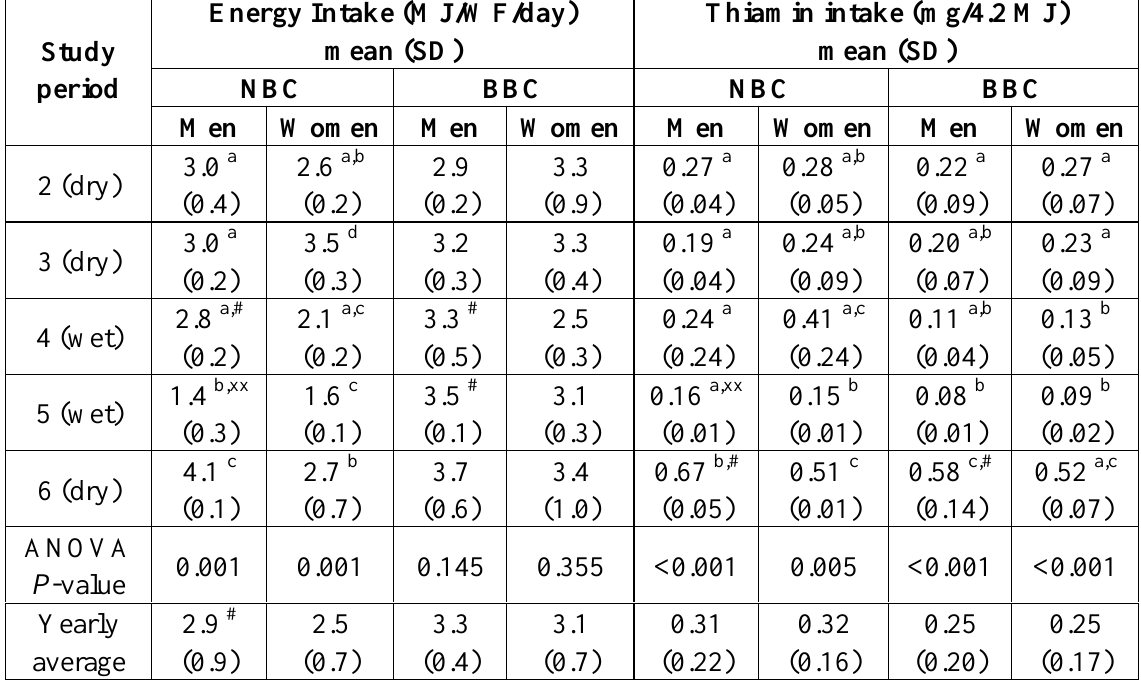
Table 3. Seasonal and gender differences in intake of energy and thiamin through the year in the study compounds 1,2 .